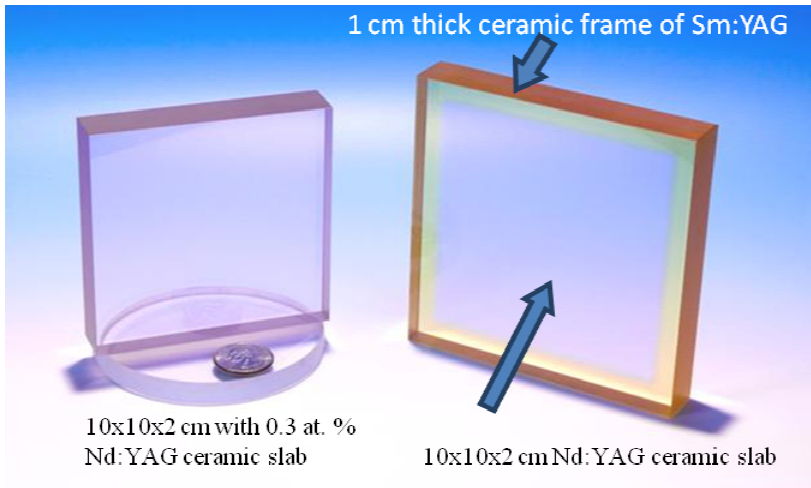
Figure 20. Large Nd:YAG ceramic laser slabs for the heat capacity laser (Adapted from